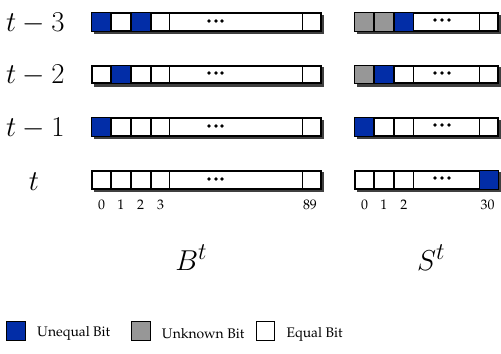
Figure 2: Plot of (A) # Monomials, (B) # Keybits in B i [0]